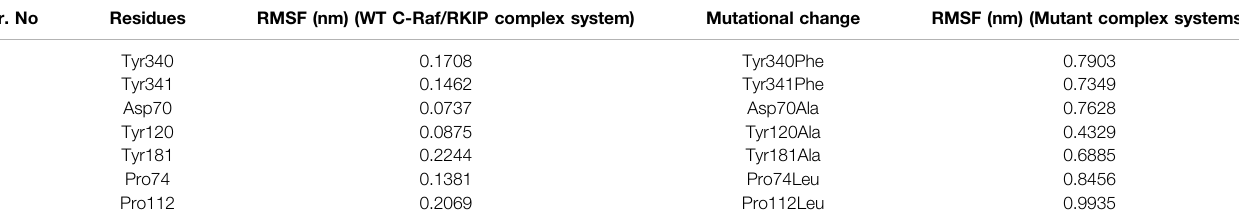
TABLE 2 | Comparative Root Mean Square Fluctuation (RMSF) analysis of residues in the wild-type (WT) and mutant complex systems. Sr.